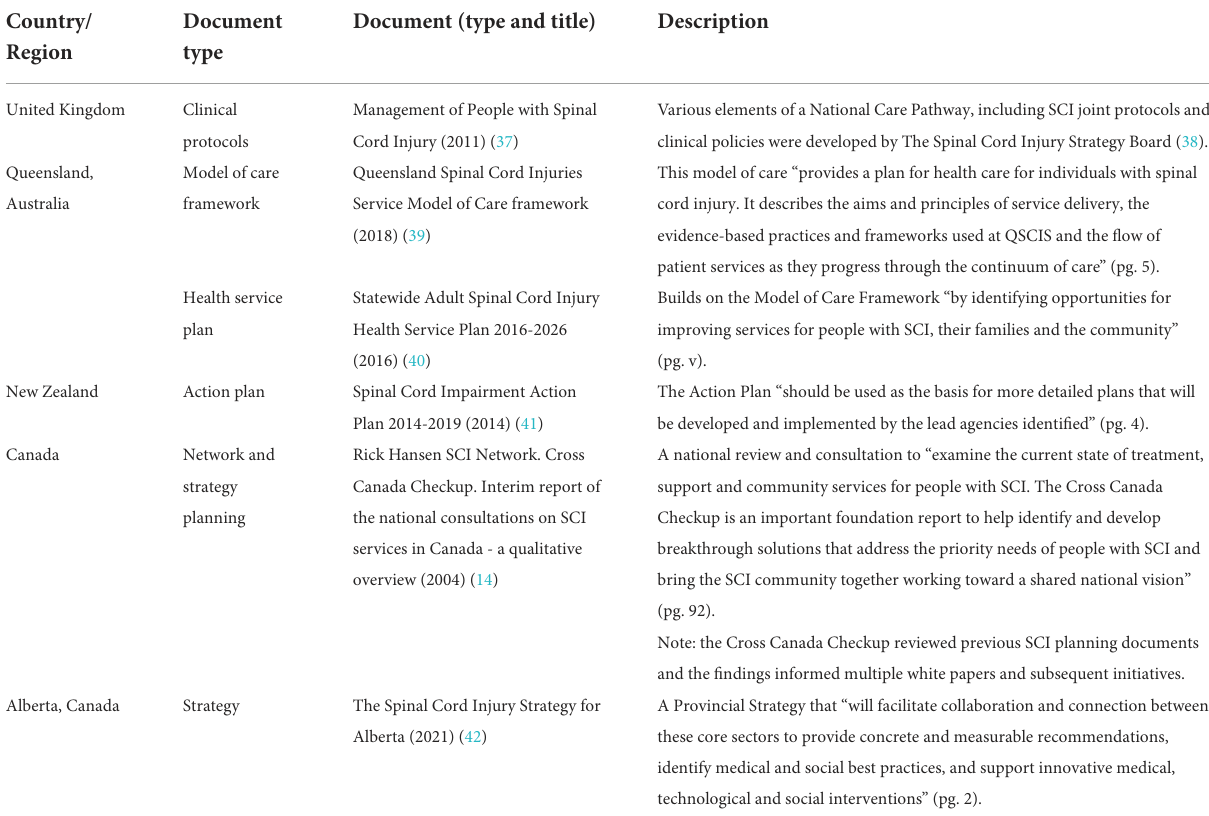
TABLE 1 Examples of SCI strategies and national